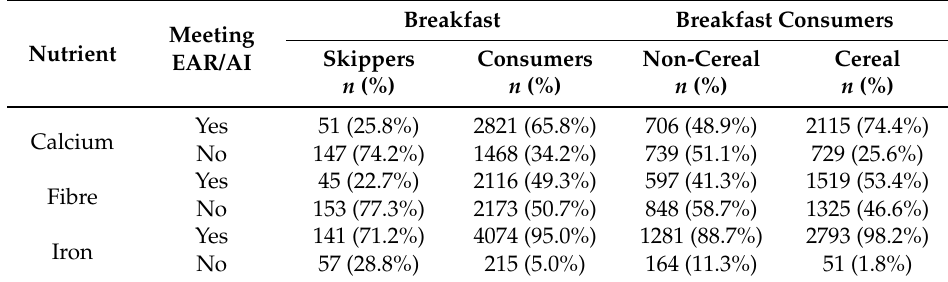
Table 4. Likelihood of meeting the estimated average requirement (EAR) for calcium and iron, and the adequate intake (AI) for